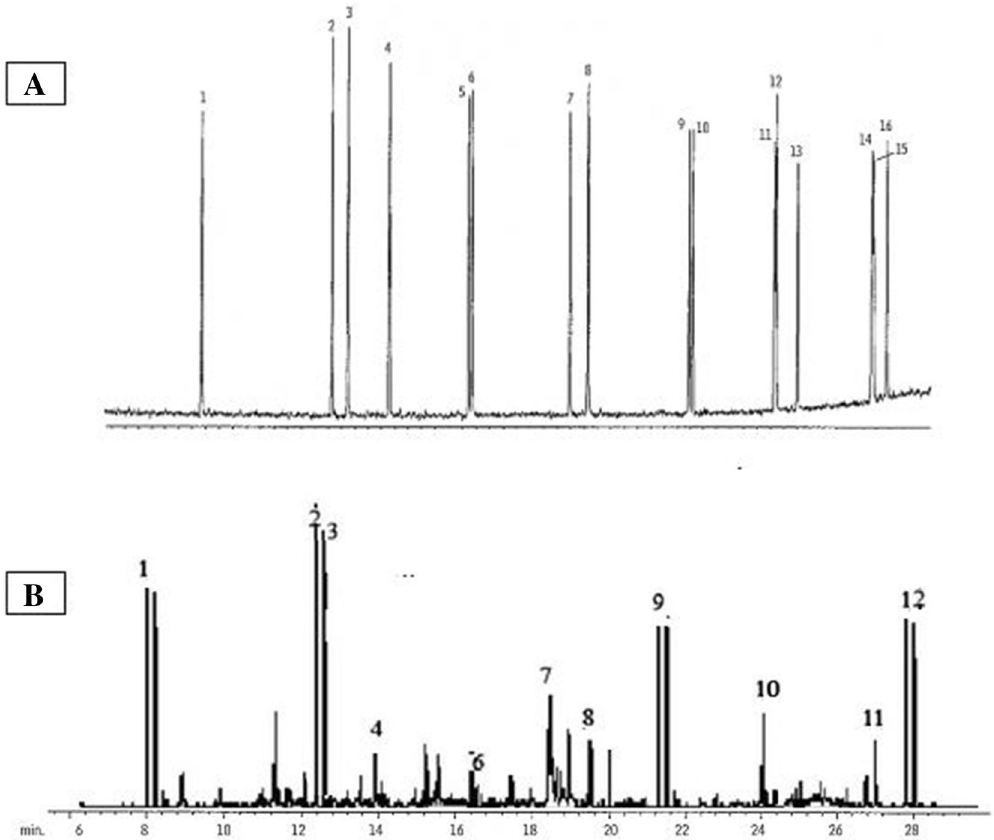
Figure 4. HPLC chromatograms of PAHs mix solution by selected Nocardia isolates, ( A ) control samples, ( B ) after 144 h incubation at 30 °C. 1. Naphthalene 2. Acenaphthylene 3. Acenaphthene 4. Fluorene, 5. Phenanthrene, 6. Anthracene, 7. Fluoranthene 8. Pyrene 9. Benzo[a] Anthracene 10. Chrysene 11. Benzo[b] fluoranthene 12. Benzo[k]fluoranthene 13. Benzo[a]pyrene 14. Indeno [1, 2, 3-cd] pyrene 15. Dibenzo [a, h] anthracene.